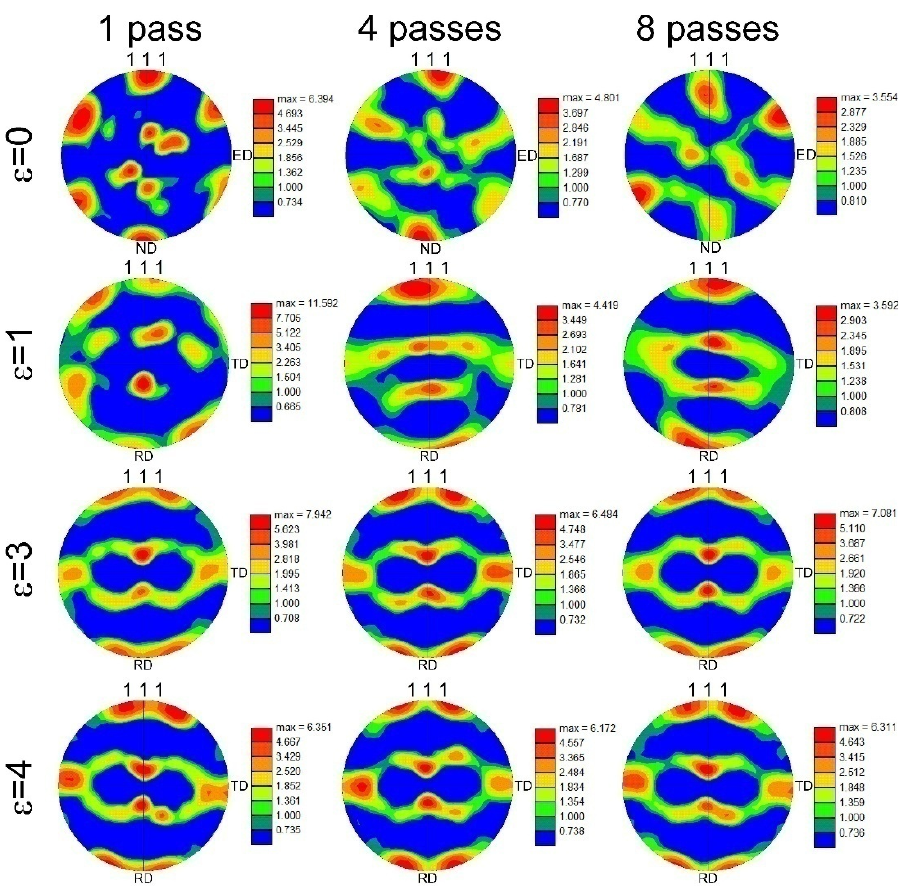
Figure 4. Deformation textures evolved in a Cu-Cr-Zr alloy during 1 to 8 passes of ECAE-Conform followed by cold rolling to a strain of 1 to 4. ED and ND indicate the extrusion and normal directions, respectively, for the ECAE-Conform samples according to commonly accepted approach [60]. TD and RD correspond to the transverse and rolling directions, respectively, for the rolled samples.